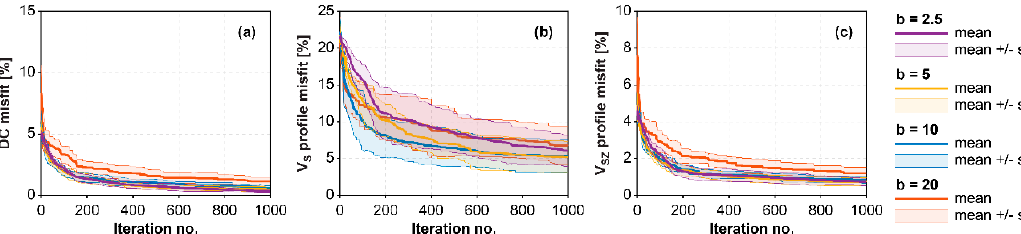
Figure 11. Model B. Data and model fitting progression for the inversion results in Figure 9.